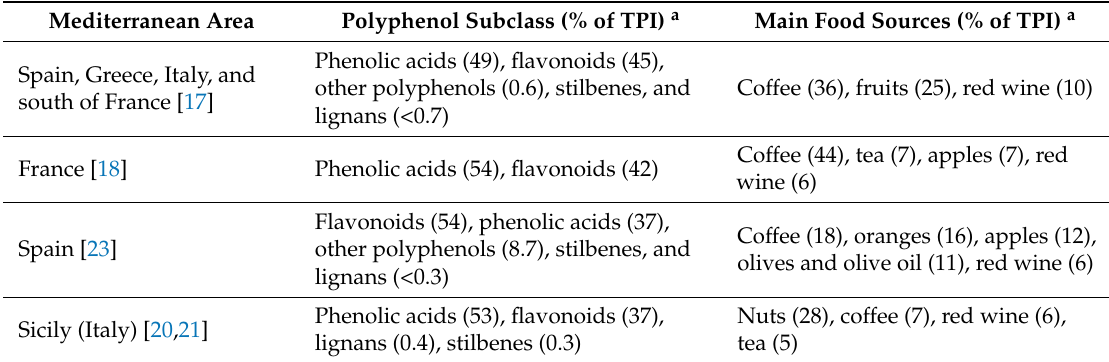
Table 1. Profile of the dietary polyphenol subclasses’ intake among the Mediterranean